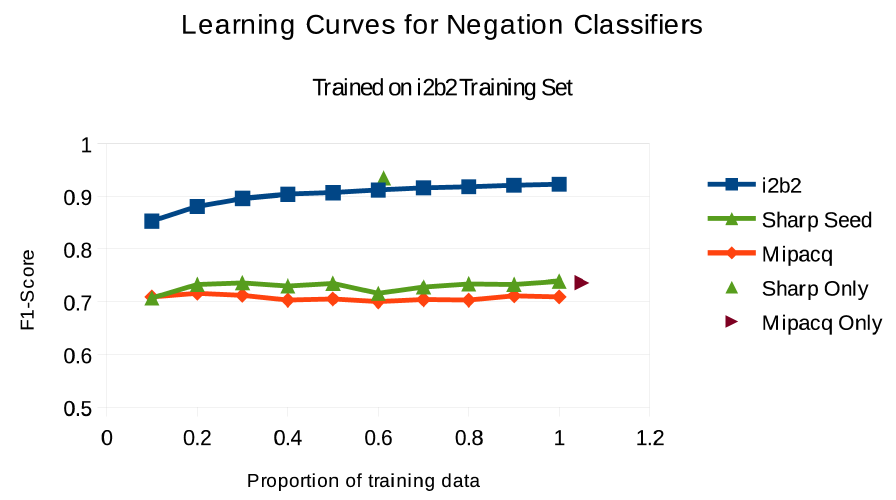
Figure 3. Learning curve for i2b2 training data on various corpora. For each proportion of the i2b2 corpus (x axis), the reported F-score (y axis) is an average of 5 randomly sampled runs.